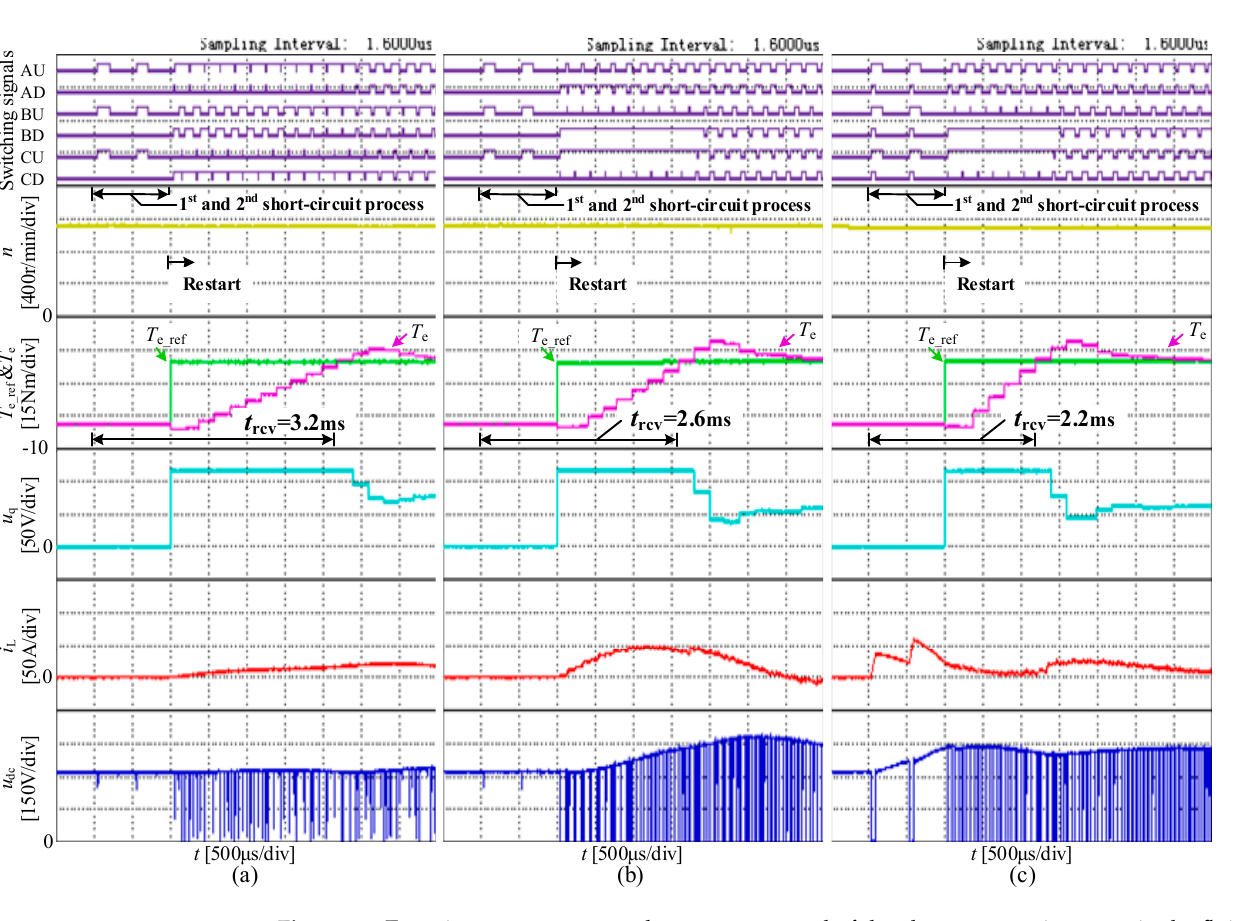
Figure 10. Experiments to compare the response speed of the electromagnetic torque in the flying restart process under three methods: ( a ) traditional ZVSM; ( b ) combination scheme of the ZVSM and the dc-link voltage boosting after restart; and ( c ) proposed SZVSM.